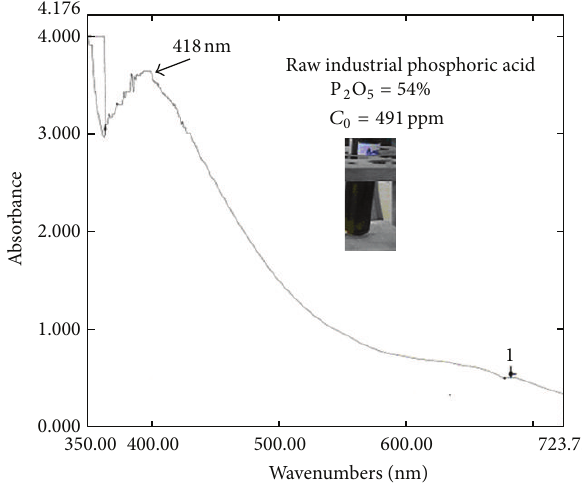
Figure1:Spectrumofwavelengthof54%industrialphosphoricacid solution.